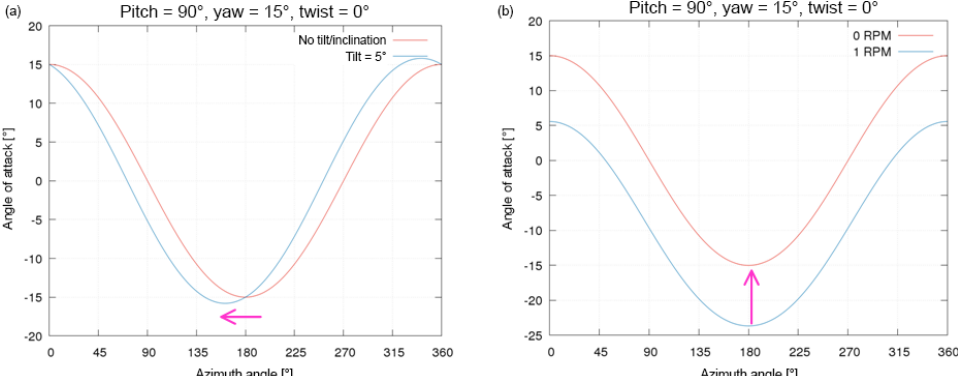
Figure 6. Variation in the angle of attack over one revolution for a wind speed of 42.5ms − 1 . (a) The effect of the yaw and tilt angle; the tilt angle shifts the curve horizontally, and the rotational speed is almost zero. (b) The effect of rotational speed; the rotational speed shifts the curve